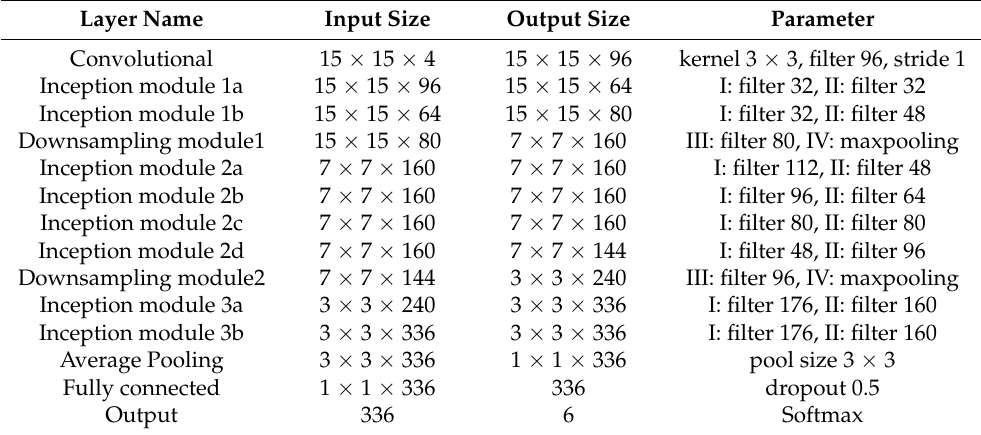
Table 4. Modified GoogLeNet model structure.